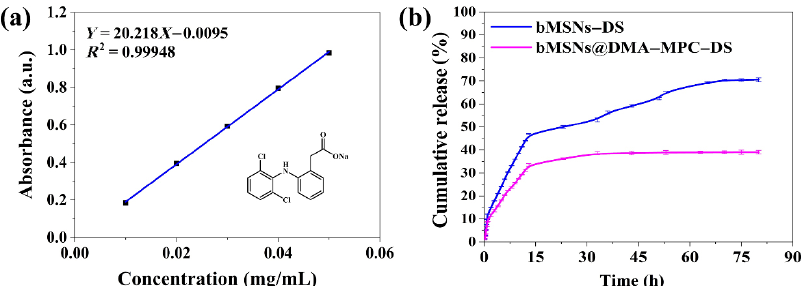
Fig. 7 In vitro drug release of the bMSNs and bMSNs@DMA–MPC (1:4) nanoparticles. (a) Standard curve of DS with different concentrations (0.01, 0.02, 0.03, 0.04, and 0.05 mg/mL) measured in PBS. (b) Drug release profiles of the nanoparticles in the PBS at 25 °C for 80